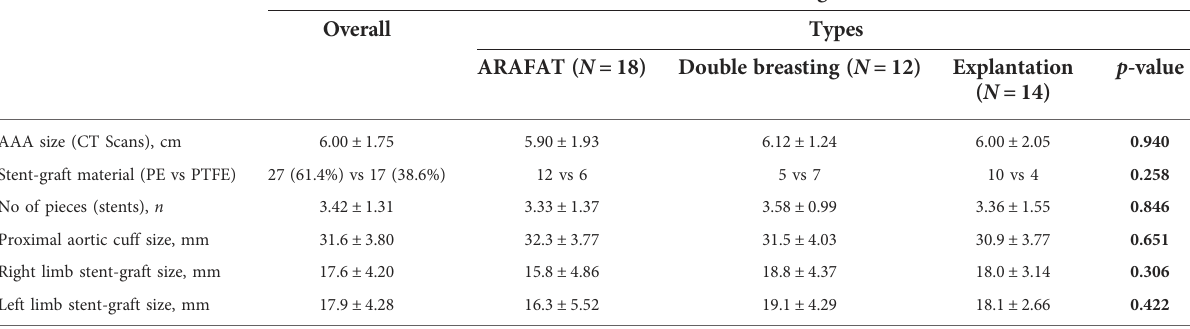
TABLE 2 Endograft characteristics employed in the primary endovascular aneurysm repair.